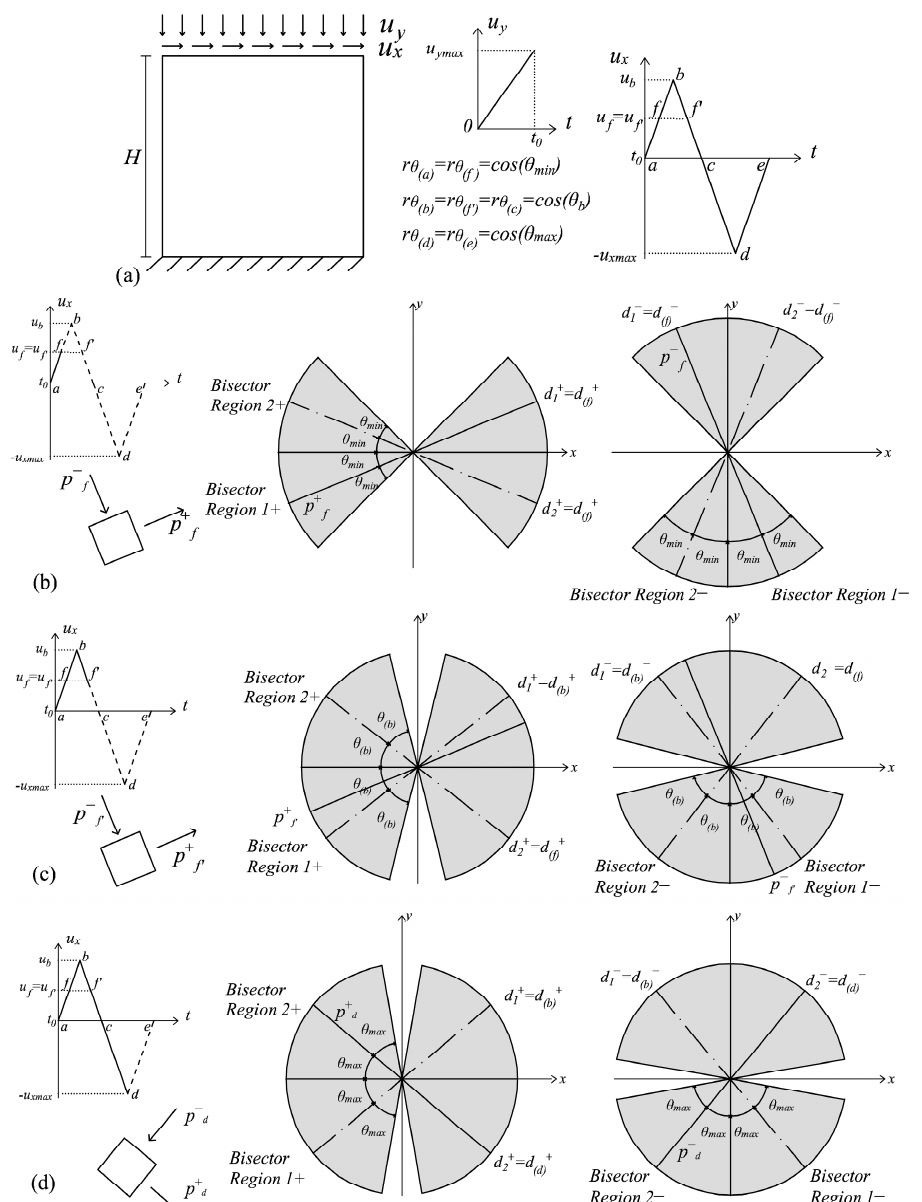
Figure 5. Multidirectional damage procedure in case of cyclic loading of Type (ii): ( a ) problem statement and identification of the damage regions and damage variables in three different situations: ( b ) in correspondence with the activation of the multidirectional procedure; ( c ) in unloading conditions and ( d ) in loading conditions.